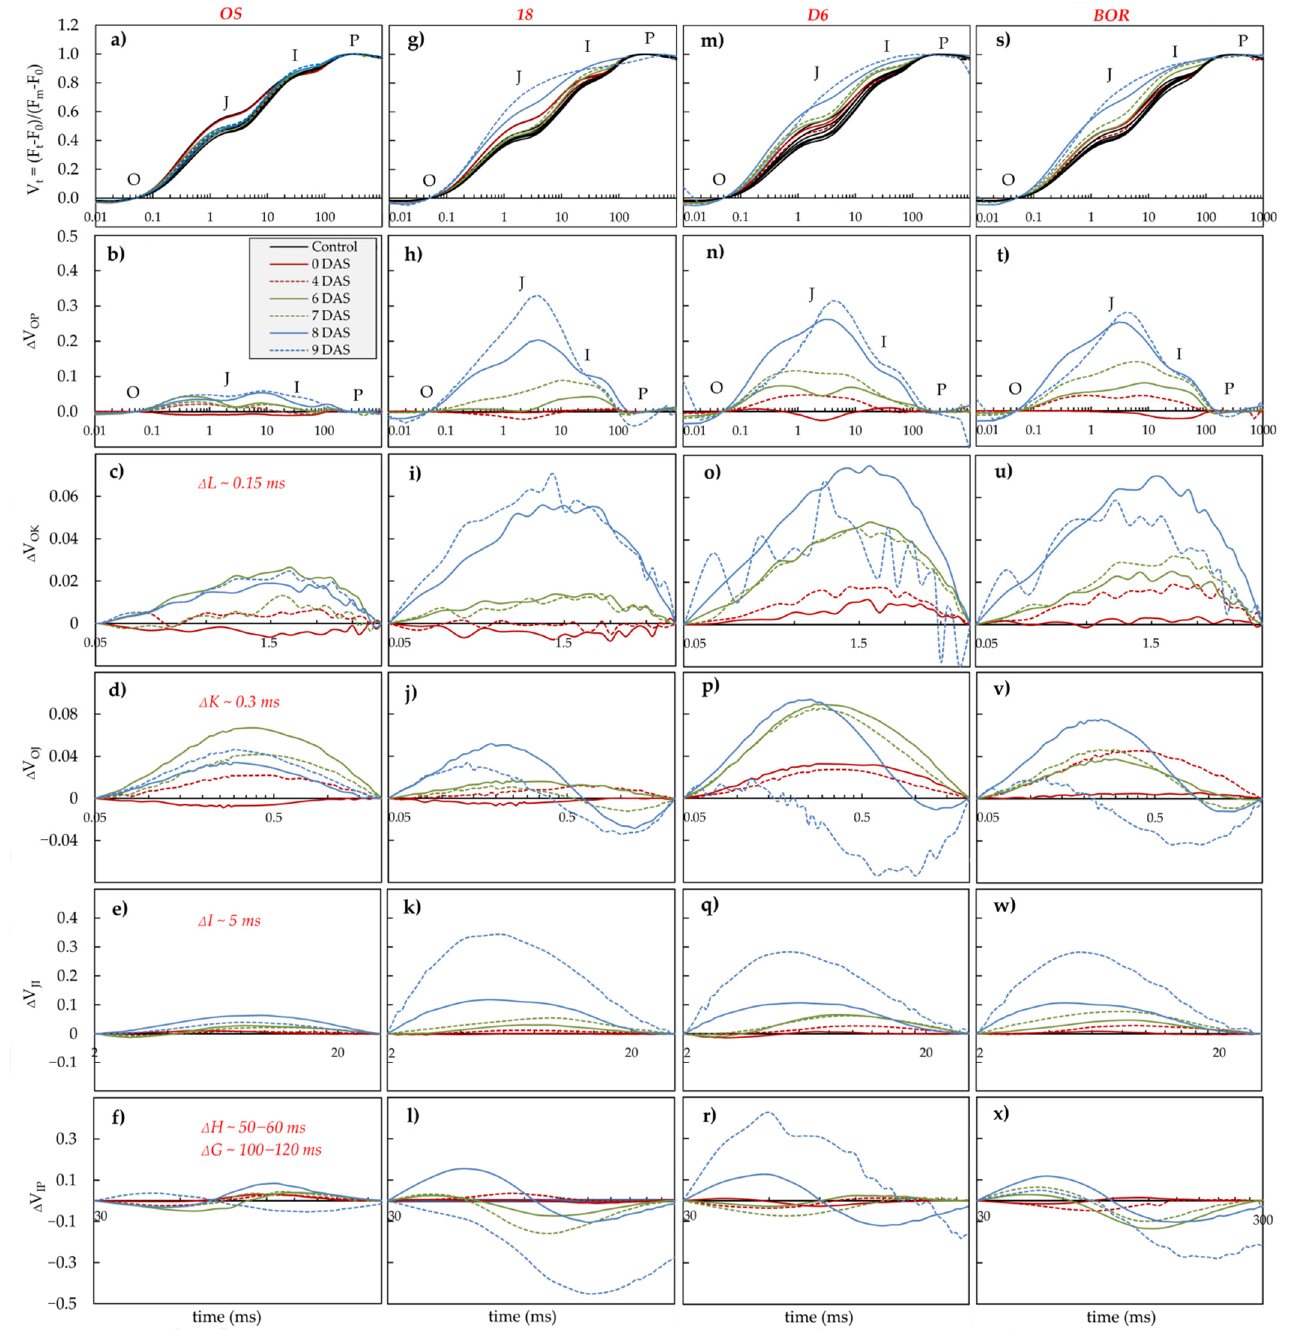
Figure 3. Changes in the shape of the chlorophyll a fluorescence transient curves in the leaves of Obla č inska sour cherry ecotypes OS ( a – f ), 18 ( g – l ), D6 ( m – r ), and BOR ( s – x ). Each curve represents the average kinetics of 20 measurements per ecotype, treatment and day after stress (DAS). The relativie variable fluorescence transient (V t ) ( a , g , m , s ) shows typical O-J-I-P steps. Average fluores- cence data normalized in the O–P ( b , h , n , t ), O–K ( c , i , o , u ), O–J ( d , j , p , v ), J–I ( e , k , q , w ), and J–P (f , l , r , x) phases of the OJIP transients revealed specific bands ( ∆ L, ∆ K, ∆ I, ∆ H, ∆ G). The difference kinetics ( ∆ V OP , ∆ V OK , ∆ V OJ , ∆ V JI , and ∆ V JP ) in the relative variable fluorescence was calculated as ∆ V t = V t (control) – V t (drought) for each ecotype and each DAS. In the drought treated leaves of ecotype BOR, positive ∆ L and ∆ K are visible at 4